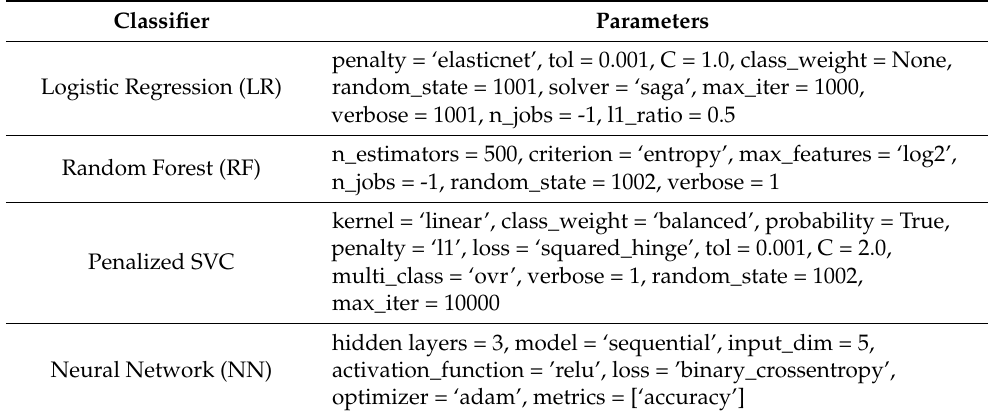
Table 2. ML and DL model